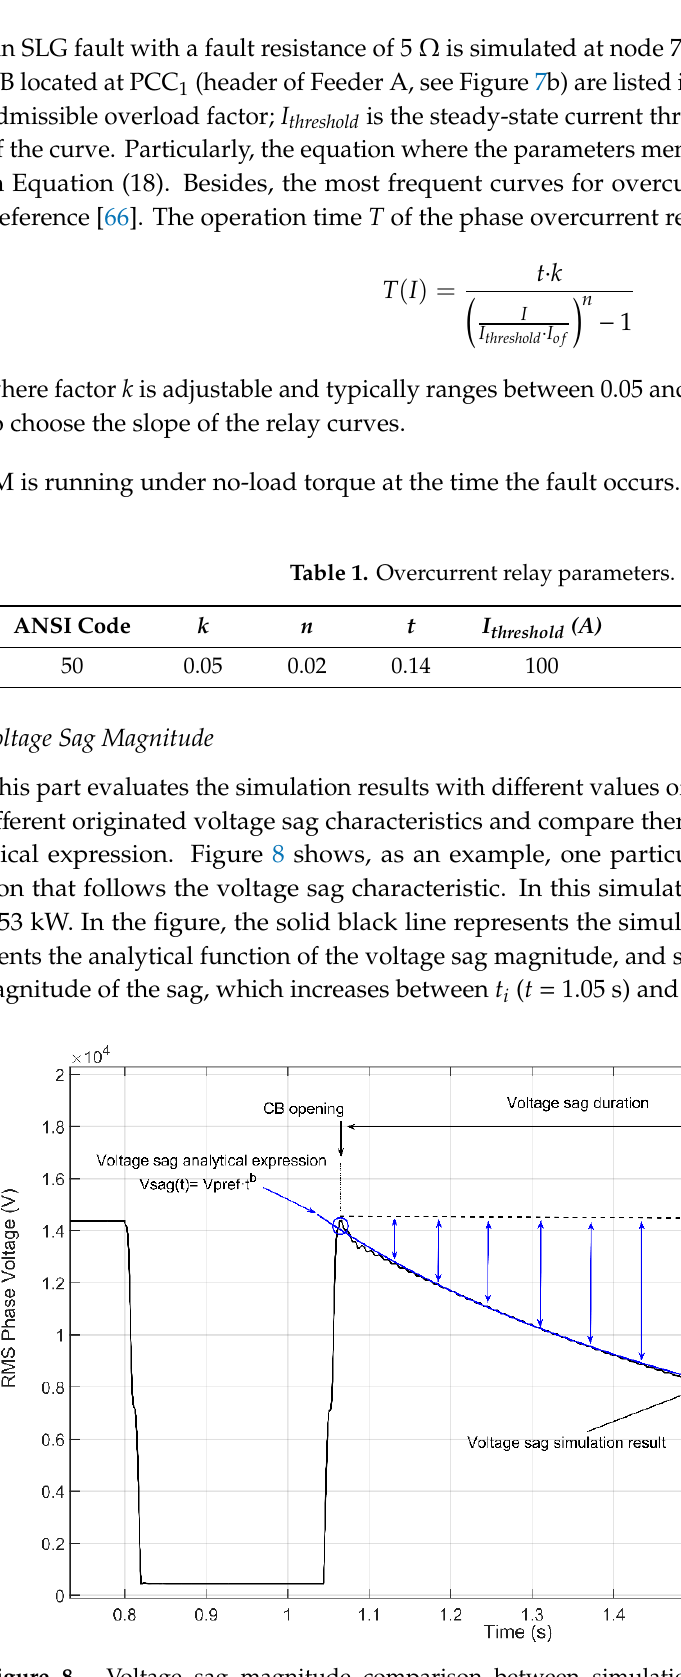
Figure 8. Voltage sag magnitude comparison between simulation results and the proposed analytical curve.